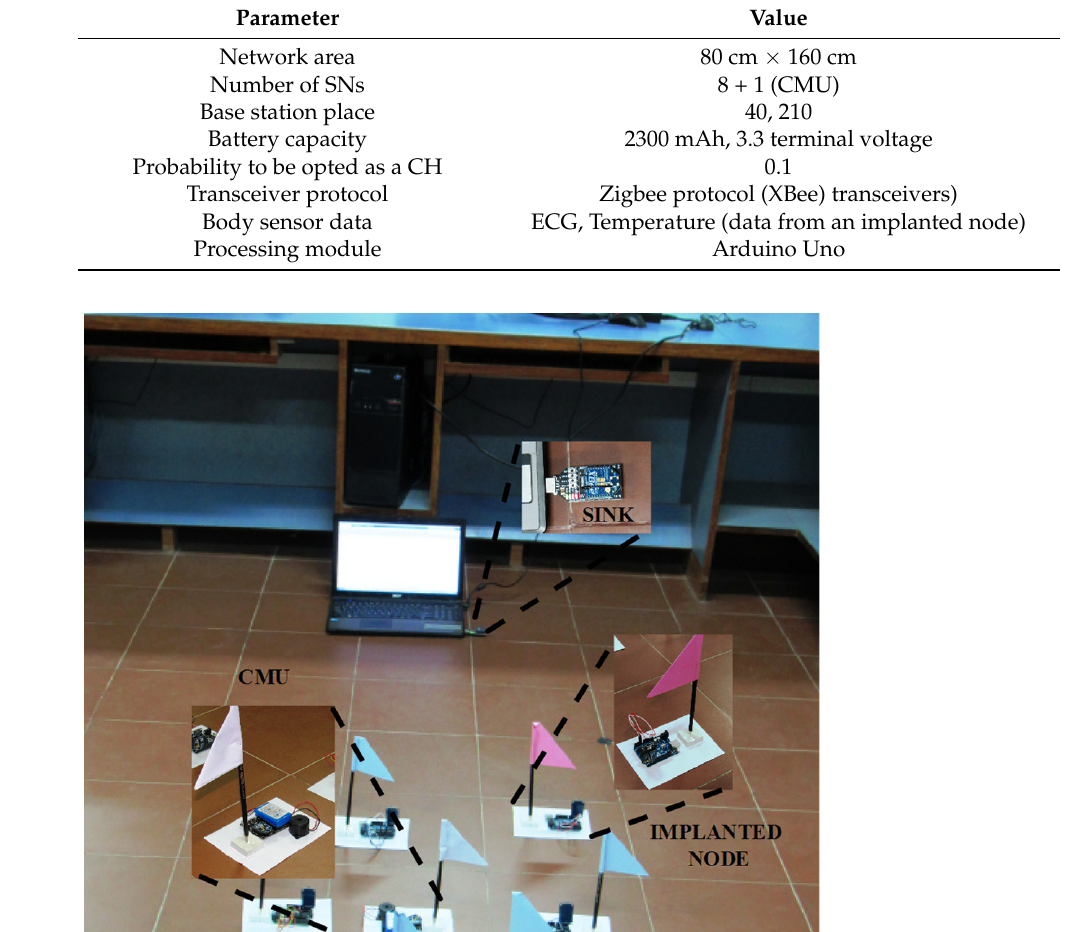
Table 4. Real-time node deployment metrics.